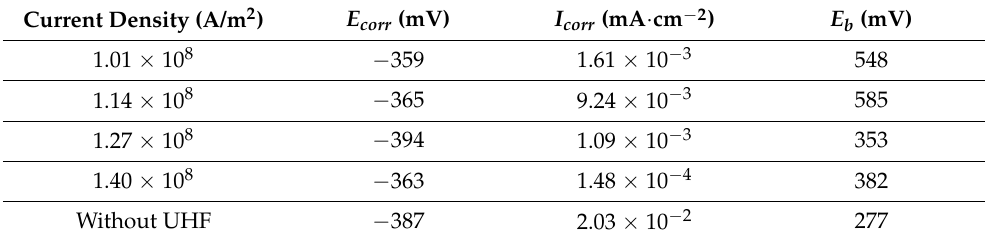
Figure 14. Polarization curves of the laser − UHF induction hybrid deposited layers under different current densities. Table 3. Corrosion data of the tested samples under different current densities.